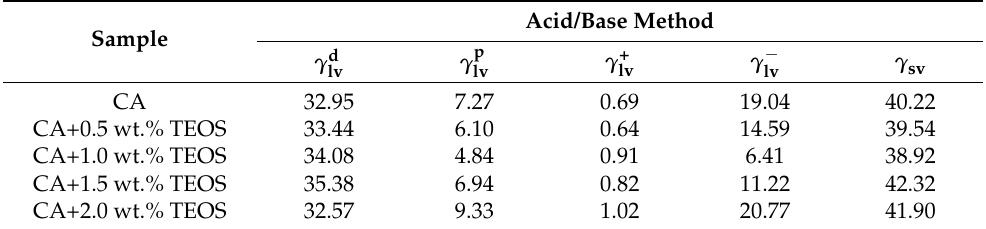
Table 5. Surface tension parameters (mN · m − 1 ) and contribution of the polar component to the total surface tension for films obtained from CA/TEOS solutions in tetrahydrofuran according to the acid/base method [Equations